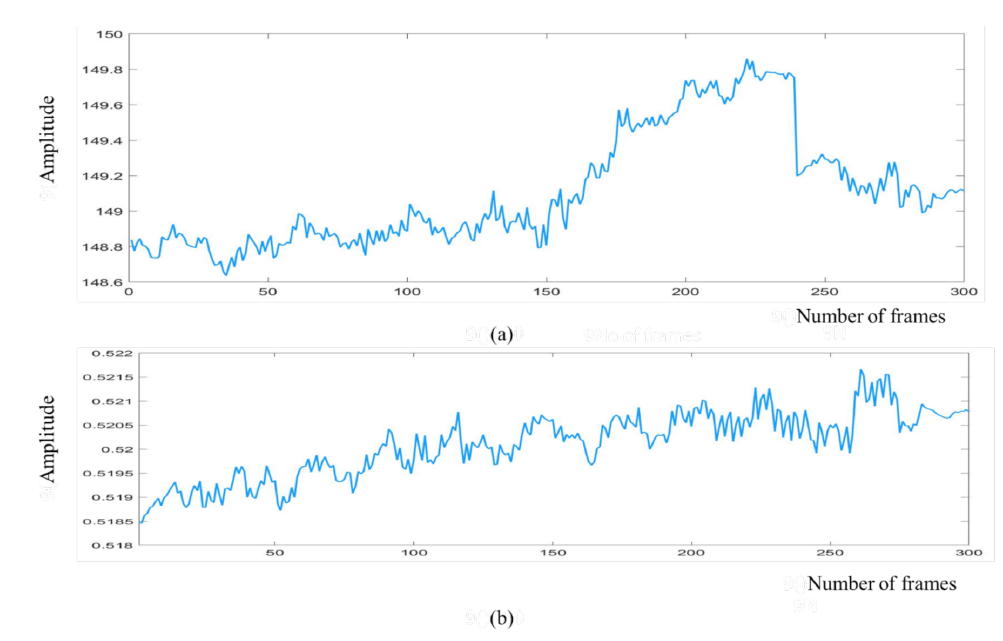
Figure 7. Raw cardiorespiratory signals for 300 frames are shown in the figure. ( a ) Raw cardiac signal, ( b ) raw respira- tory